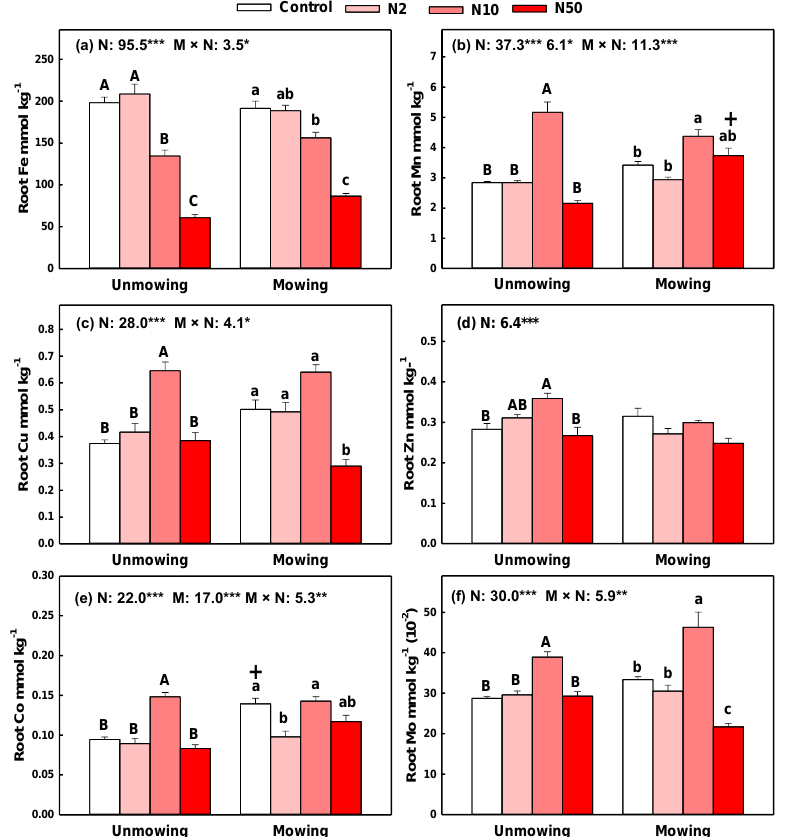
Figure 4. Effects of N addition on the contents of six micronutrients (Fe, Mn, Cu, Zn, Co, and Mo) with unmowing and mowing treatments in belowground roots. Note: Data are presented as means ± standard error. The results of two-way ANOVA (F values) are shown at the top of each figure. *, **, *** indicates significant differences at p < 0.05, 0.01, 0.001, respectively. Different uppercase or lowercase letters denote significant differences ( p < 0.05) between control and N addition plots with unmowing and mowing treatments. Symbols +, − indicate significant positive or negative effects of mowing compared with their counterparts with the same N addition rate at p < 0.05. Only items with significant cases were shown.